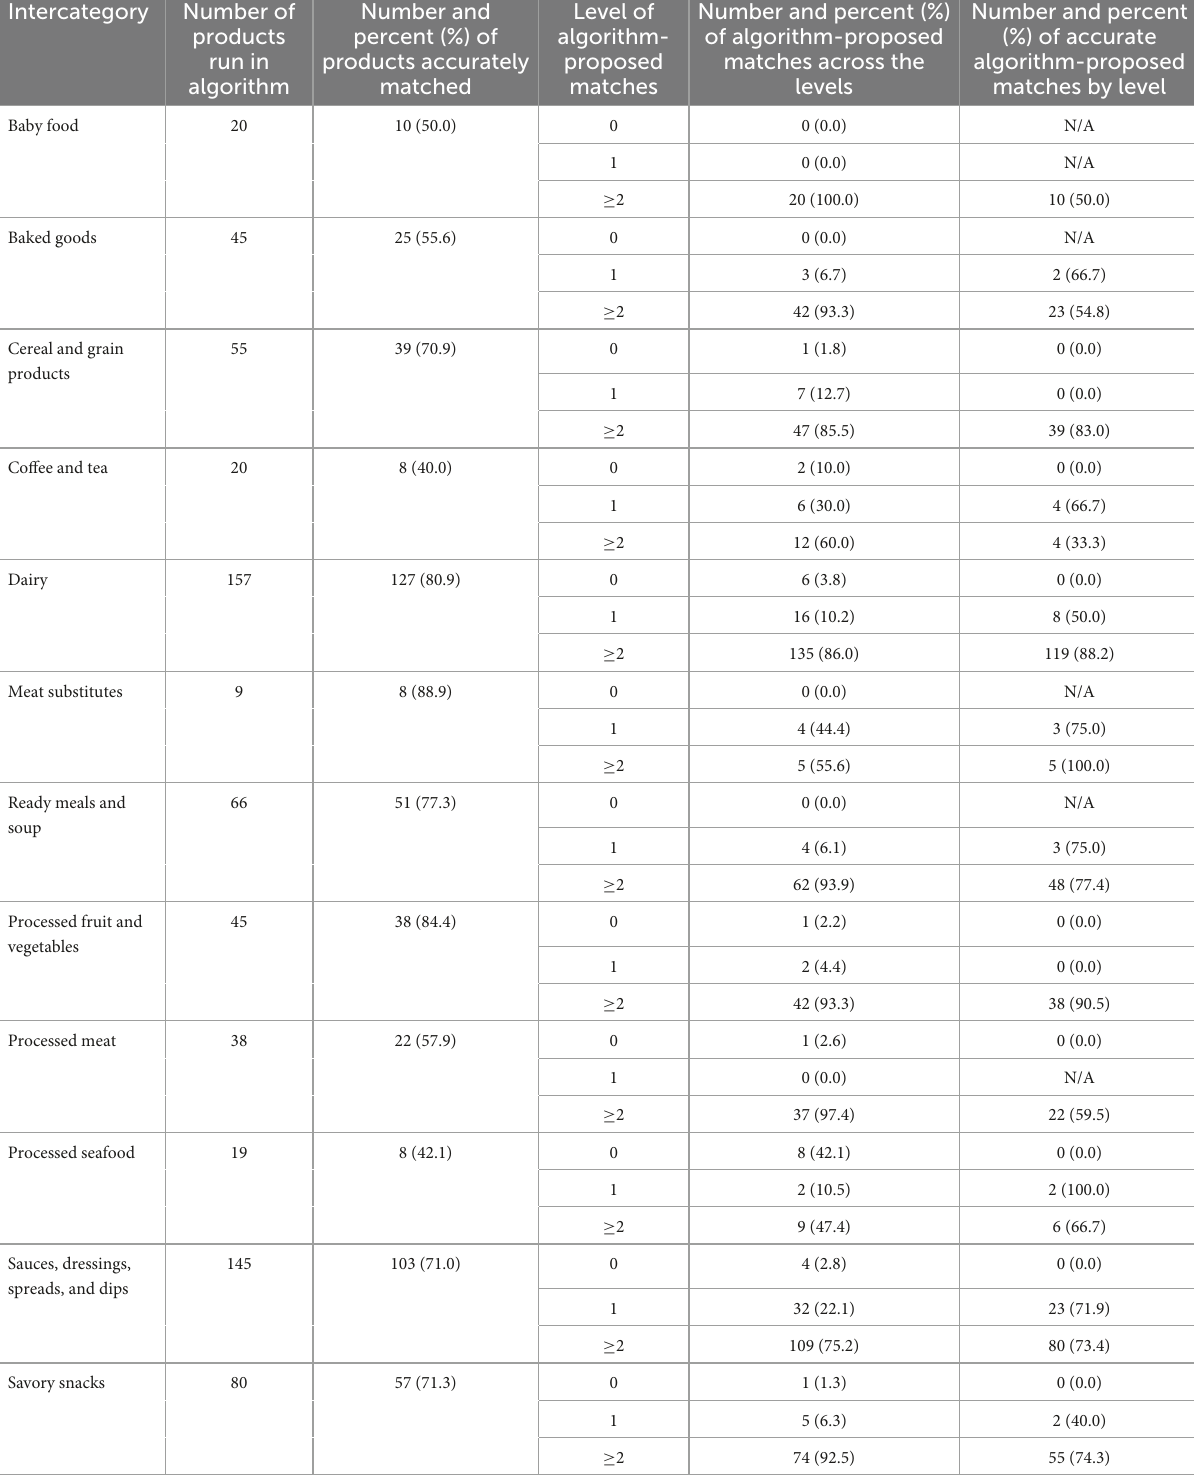
TABLE 3 Number of Euromonitor products run through the algorithm and the number and percentage of products accurately matched overall (total and by intercategory). Additionally, by intercategory and by level of algorithm-suggested matches, the numbers and percentages of proposed matches and of accurate such